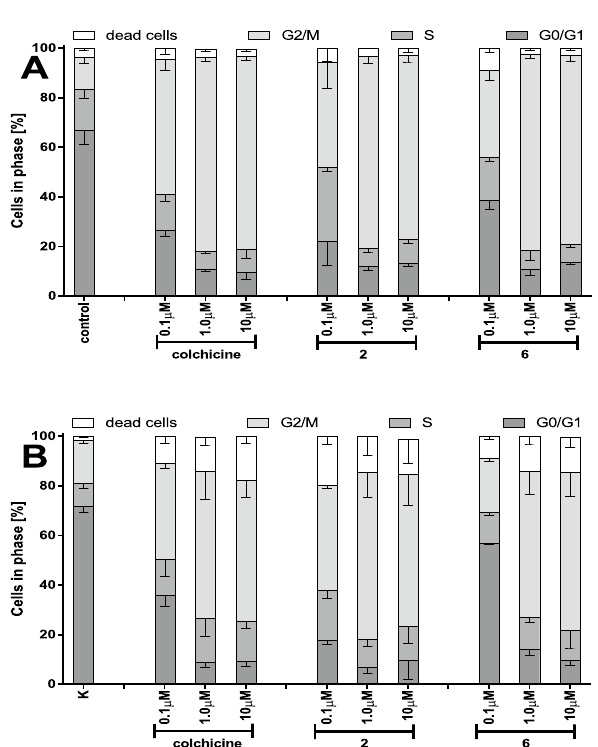
Figure 3. Effect of tested compounds on cell cycle distribution in SKOV-3 ovarian cancer cells. Cells were treated with tested compounds: colchicine 1 , 2 and 6 at concentrations 0.1 μM, 1.0 μM, and 1.0 μM for 24 h ( A ) and 72 h ( B ). After incubation cells were stained with propidium iodide and analyzed using flow cytometry. Statistical significances are marked with asterisks (*) p < 0.05; (**) p < 0.01; (***) p <